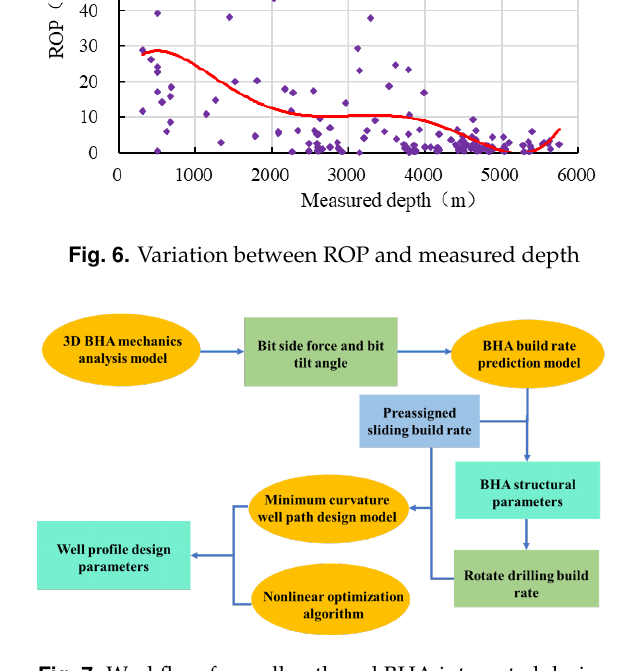
Fig. 7. Workflow for well path and BHA integrated